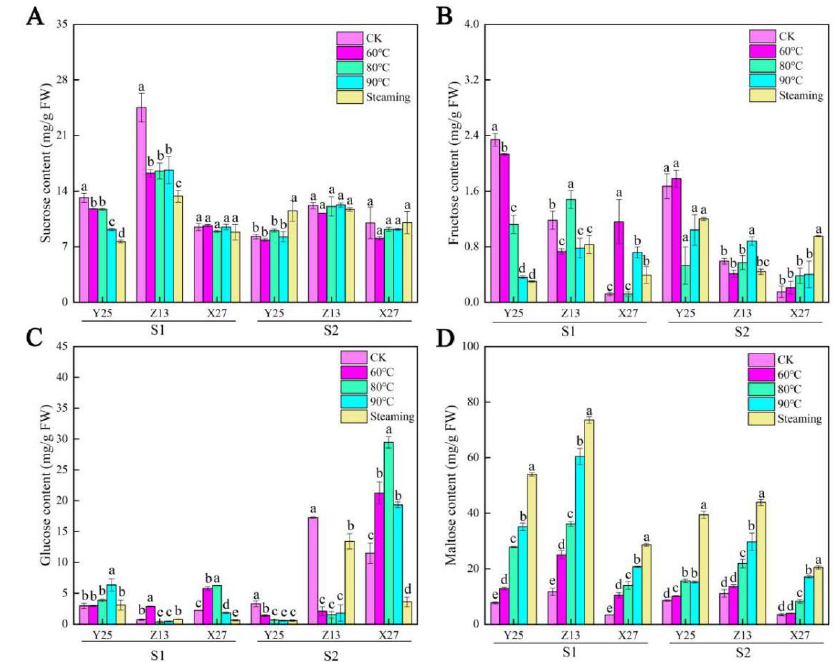
Figure 2. ( A ) Sucrose, ( B ) fructose, ( C ) glucose, and ( D ) maltose contents in three sweetpotato culti- vars under different temperature treatments. The changes of sucrose, fruc-tose, glucose, and maltose content in three sweetpotato cultivars under different temperature treatments, respectively. Bars not sharing a common letter differ ( p < 0.05) by one-way ANOVA and Tukey’s multiple comparison